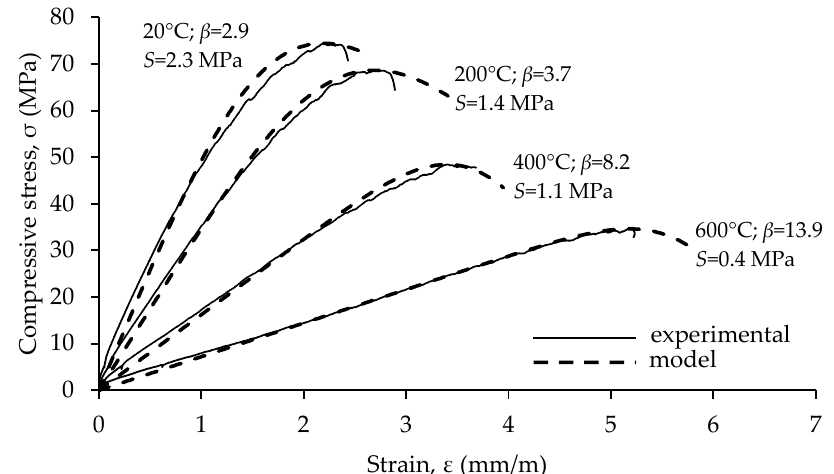
Figure 17. Comparison between model and experimental values.